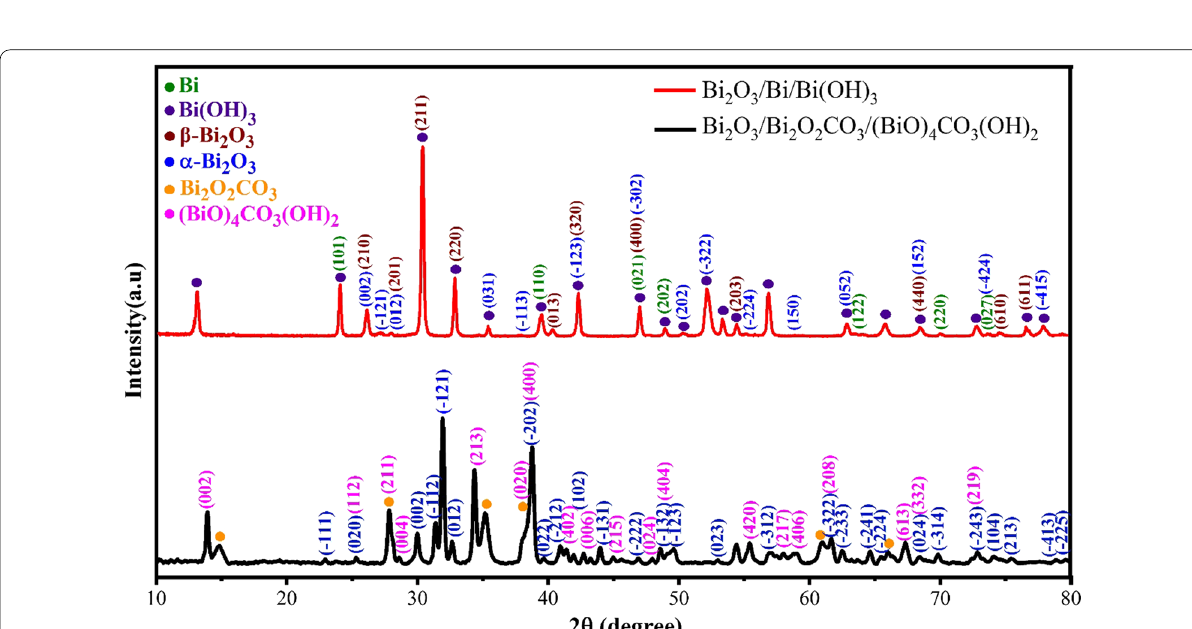
Fig. 2 XRD patterns of synthesized nanostructures by electrical arc